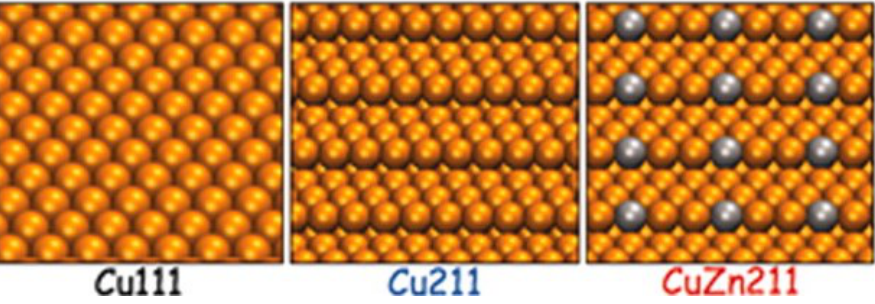
Figure 2. Density functional theory (DFT) calculation models for each catalyst facet. Reprinted with permission from [30]. Copyright (2012) American Association for the Advancement of Science.